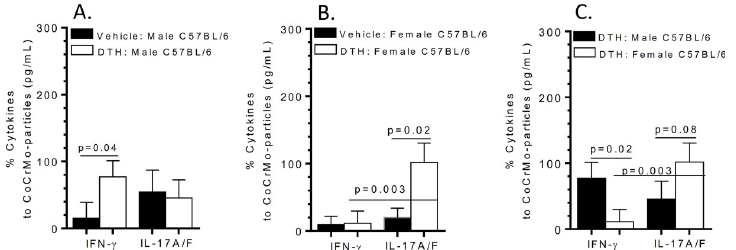
Fig 5. Female vs male BL/6 lymphocyte cytokine responses to CoCrMo-alloy particle challenge. Percentage increase of lymphocyte cytokine production of IFN-gamma or IL-17A/F in response to CoCrMo-alloy particle challenge from either vehicle or metal-DTH (A) male BL/6 or (B) female BL/6 mice; calculated using cytokine production to CoCrMo-alloy particle vs. respective negative control media cell cytokine production. (C) Comparison of male vs. female metal-DTH lymphocytic cytokine responses to CoCrMo-alloy particle challenge. Data represents two independent experiments with n = 4–5 mice/group in each experiment. Data are shown as the mean ± SEM. Statistical significance was determined by unpaired Mann-Whitney test.